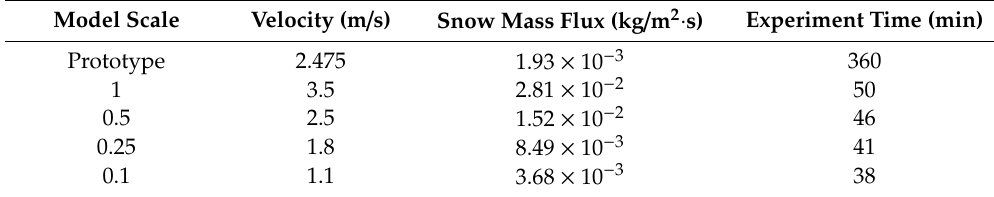
Table 3. Environmental conditions of the scale experiments.